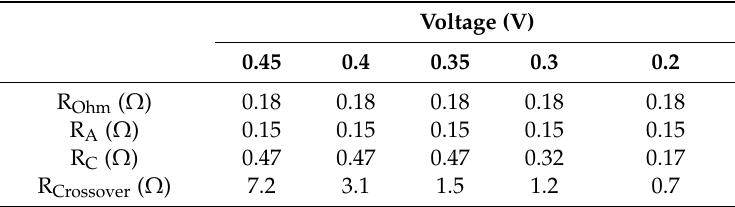
Table 1. EIS data estimated from the equivalent electric circuit (EEC) proposed in Figure 3; methanol concentration: 1